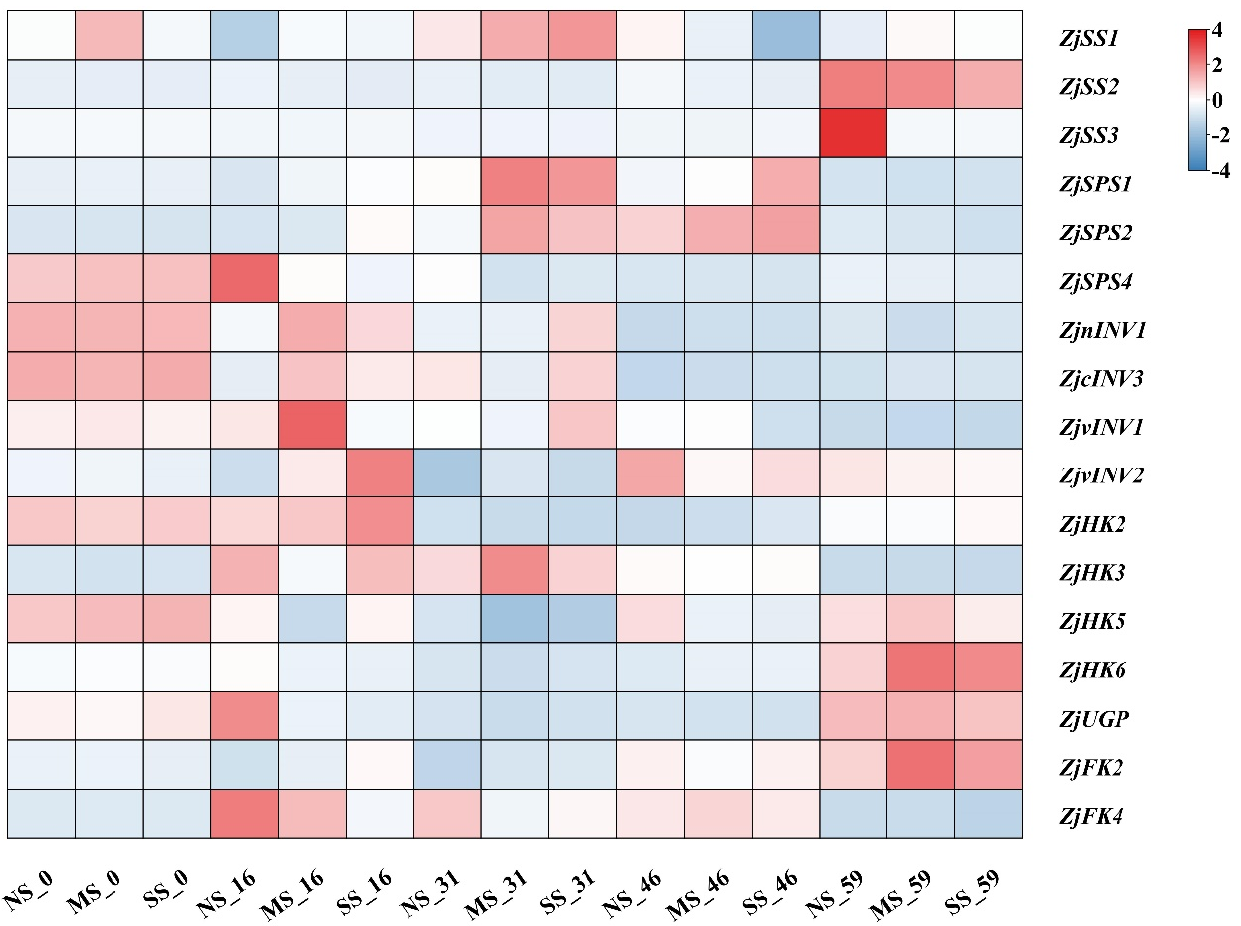
Figure 4. Heatmap analyses of gene expression involved in sugar metabolism in leaves. Sucrose synthase (SS), sucrose phosphosynthase (SPS), invertase (INV), fructokinase (FK), pyrophosphorylase (UGP), hexokinase (HK). Colors from blue to red indicate that the levels of gene expression are low to high, and a redder color indicates that the expression levels of a gene are high. The genes expression in the fruit of NS-0 were all standardized to one. The expression levels of genes were compared by log 2 fold change and averaged, and TBtools were used for heatmap analyses. The same is below.